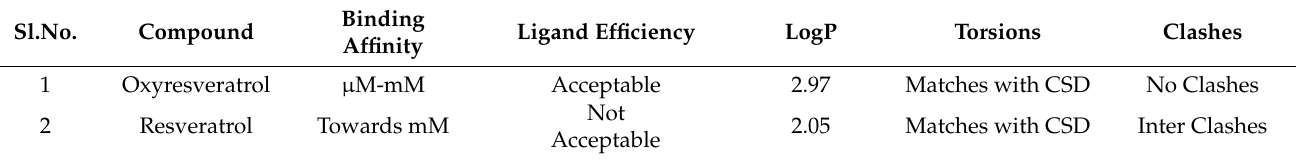
Table 1. Molecular docking parameters for 2 ligands against the protein 2WNW. Binding affinity is represented as a range as it cannot be predicted as an absolute value accurately through in silico methods. Torsion bonds were statistically compared with Cambridge Structural Database to understand the co-crystal formation of the compound docked against the protein. Inter- and intra-ligand clashes were analyzed and reported.